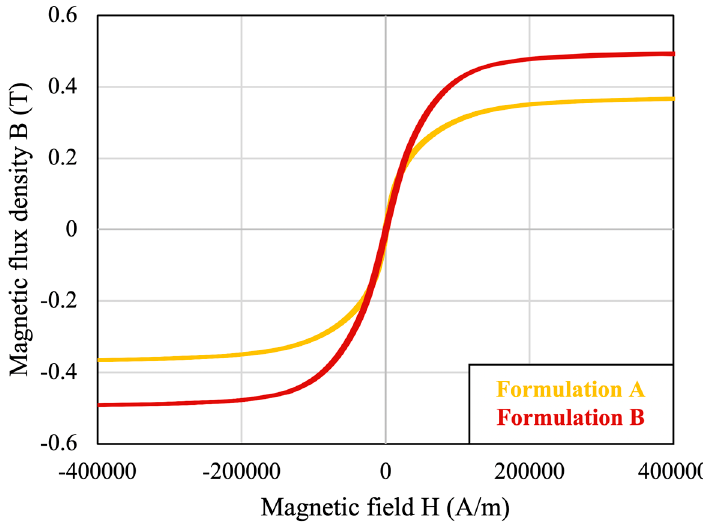
Figure 4. B-H curves measured on Formulations A and B.